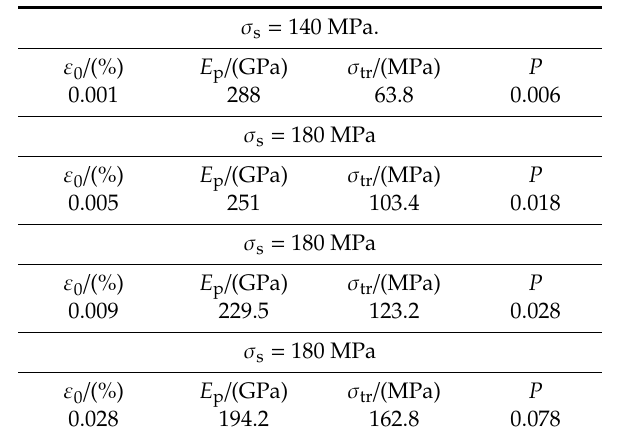
Table 6. The tensile stress–strain curve, tangent modulus, interface debonding fraction and broken fiber fraction of 2D SiC / SiC composite subjected to stochastic loading of σ s = 140, 180, 200 and 240 MPa.